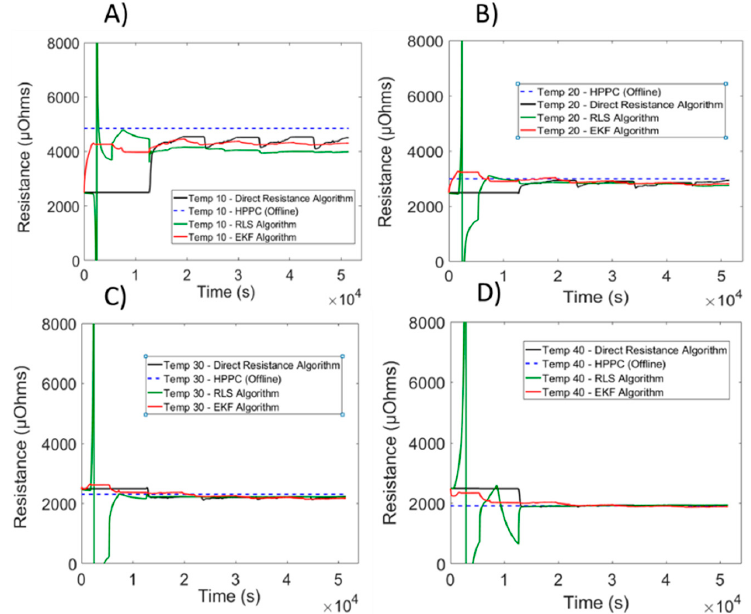
Figure 7. Resistance estimations from HPPC test, EKF algorithm, RLS algorithm and DRE algorithm for cell #1 (fresh cell) at temperatures of 10 °C ( A ), 20 °C ( B ), 30 °C ( C ) and 40 °C ( D ).